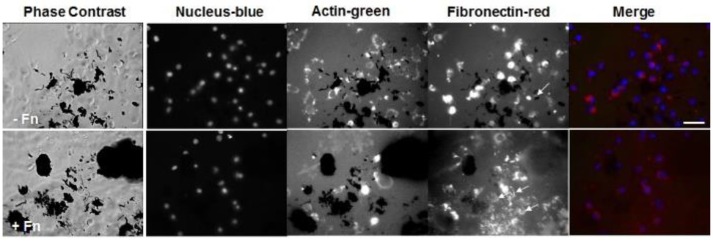
Fluorescence images of NIH 3T3 cells on PEG/MWCNTs hydrogels (−Fn) and fibronectin-coated PEG/MWCNTs hydrogels (+Fn) at 6 h in serum-free medium. Nucleus was stained with Hoechst 33258 (blue), actin was stained with Alexa 488 phalloidin (green) and fibronectin was stained with polyclonal anti-fibronectin (red). Scale bar is 50 μm. Arrows indicate extracellular fibronectin.